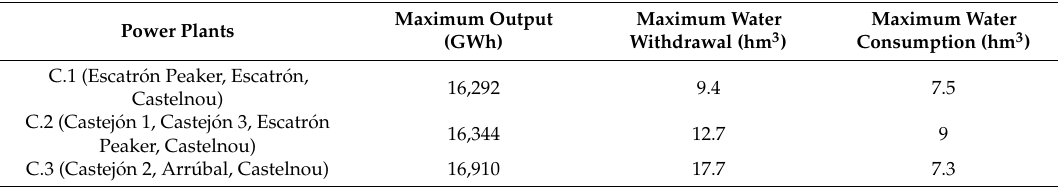
Table 8. Set of combinations in Scenario